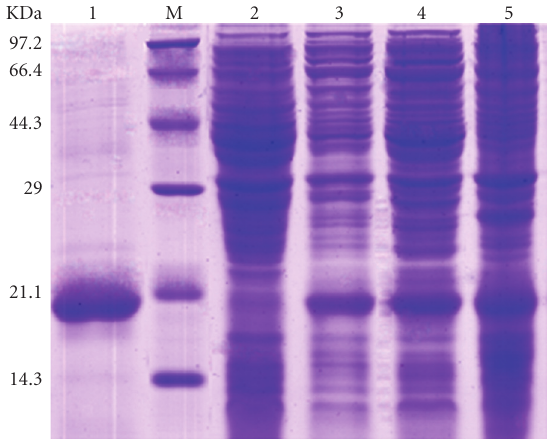
Figure 2: SDS-PAGE analysis of IL-33 purification and identifica- tion. Lane M, protein molecular weight marker; Lane 1: purified IL-33; Lane 2: total cell lysate before induction at 25 ◦ C; Lane 3: supernatant fractions of total cell lysate after induction; Lane 4: pellet fractions of total cell lysate after induction; Lane 5: total cell lysate after induction at 25 ◦